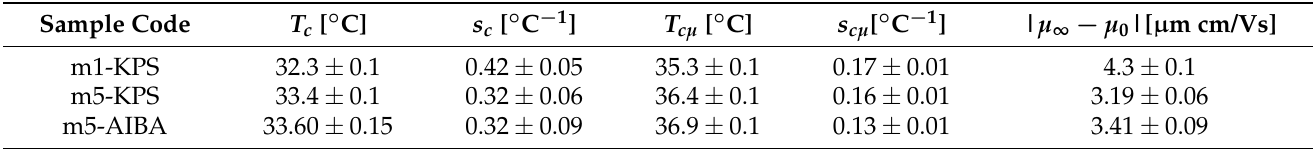
the charge distribution within the networks as temperature varies. Table 2. Volume phase transition temperatures ( T c ), electrokinetic transition temperatures T c µ and relative normalized slopes ( s c and s c µ ) obtained via Boltzmann fits as detailed in the text.